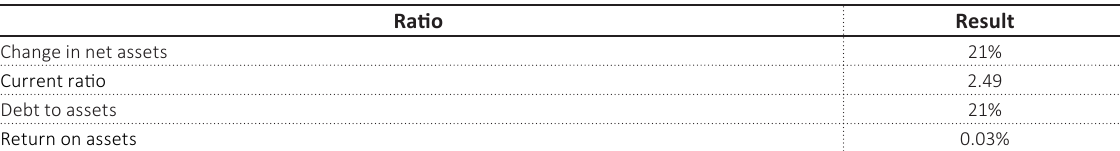
Table 8. Ratios benchmark of